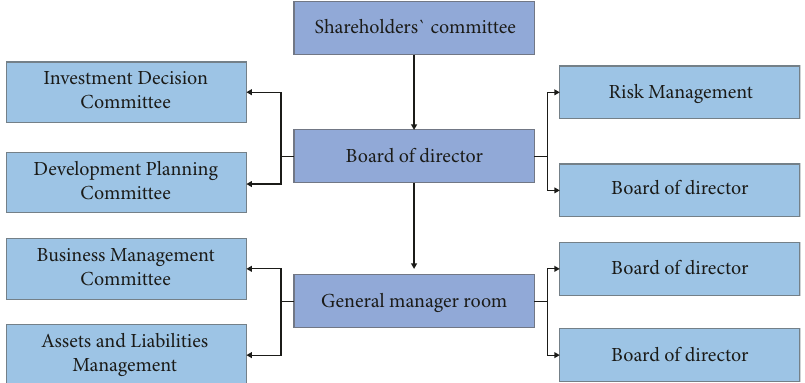
Figure 1: Organizational structure of insurance company A.